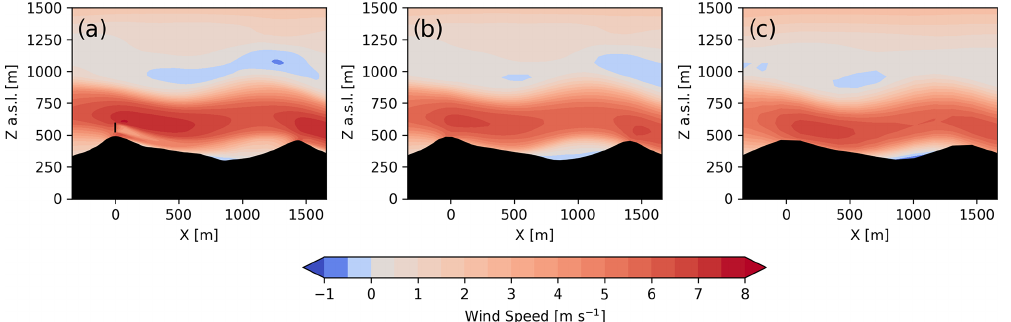
Figure A4. Transect of 1h time-averaged wind speed for (a) d05 ( (cid:49)x = 10m), (b) d04 ( (cid:49)x = 50m), and (c) d03 ( (cid:49)x = 150m) during the stable case